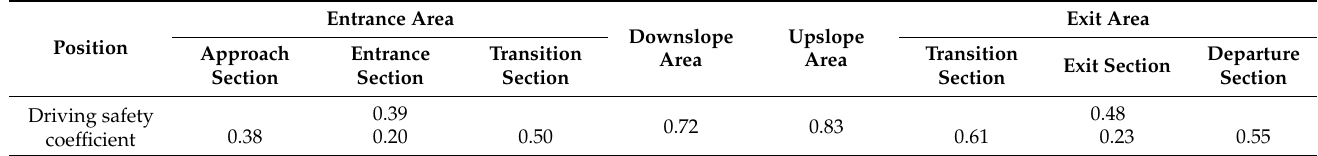
Table 2. Driving safety coefficient in different areas of the undersea